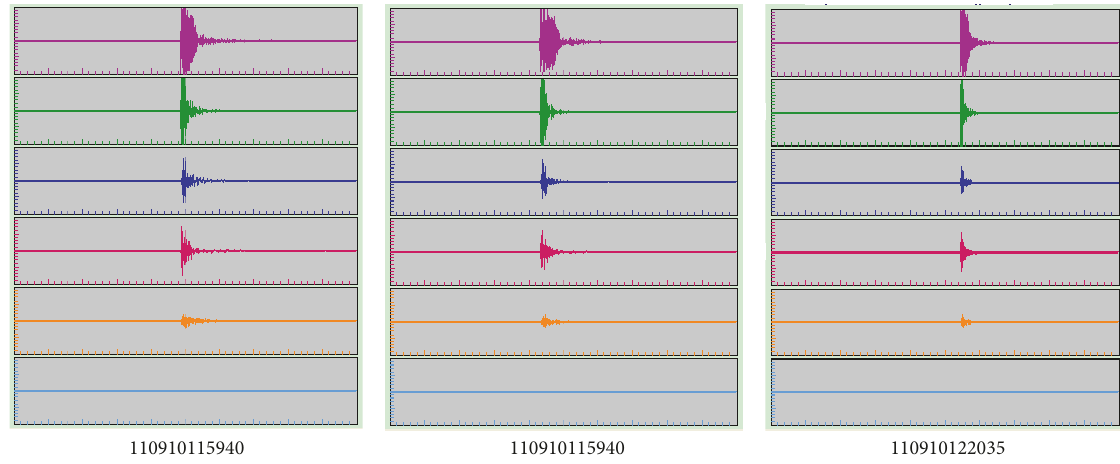
Figure 12: Propagation effect of vibration wave along the roadway (original